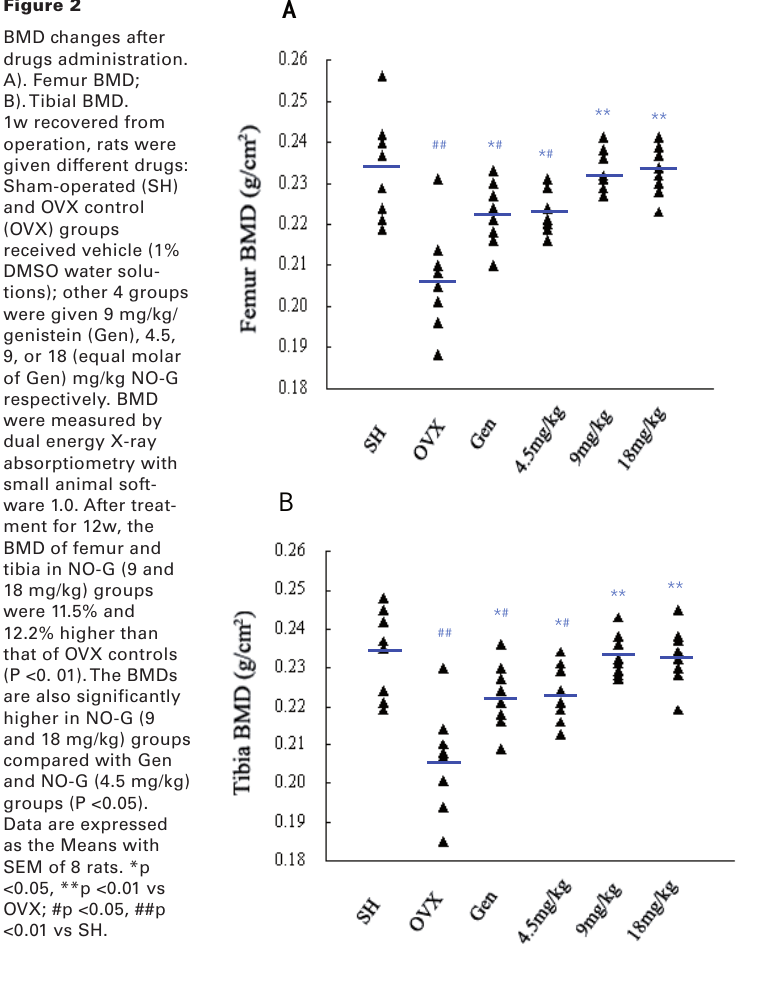
BMD changes after drugs administration. A). Femur BMD; B). Tibial